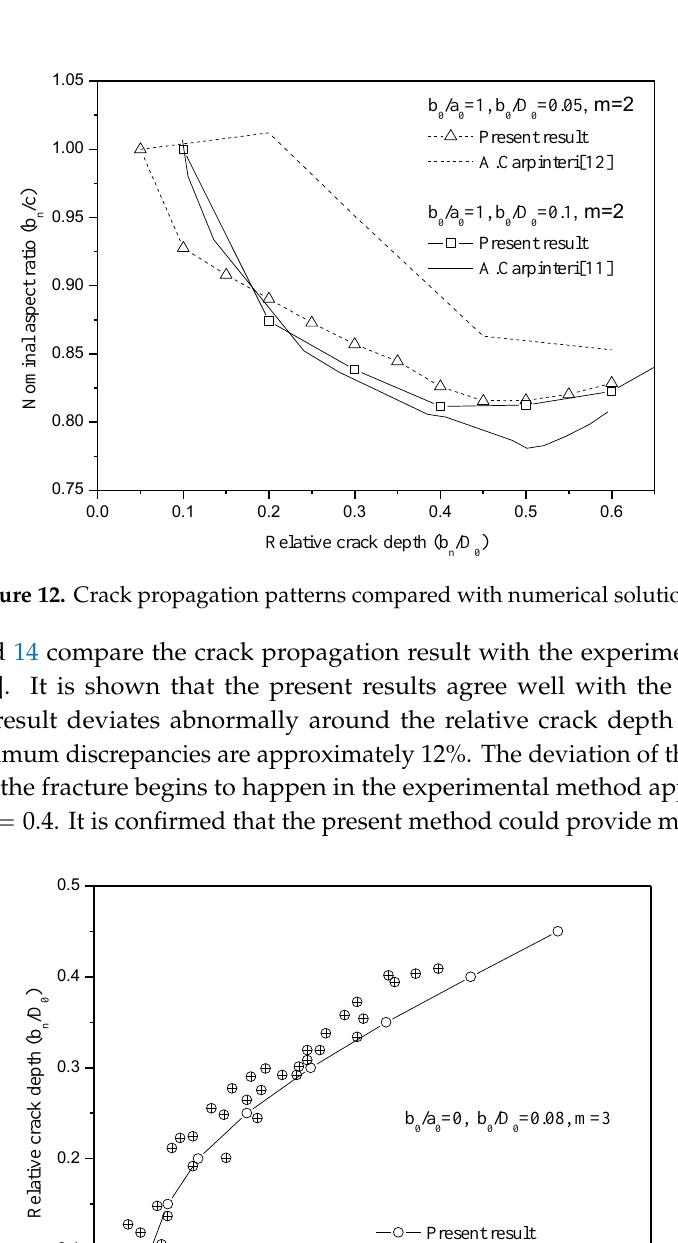
Figure 13. Relationship of crack propagation with depth and chord length compared with experimental data.